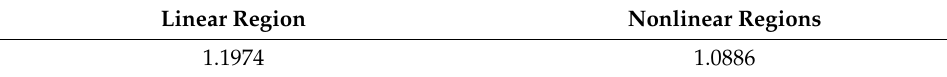
Table 3. RMSE of trajectory tracking error.